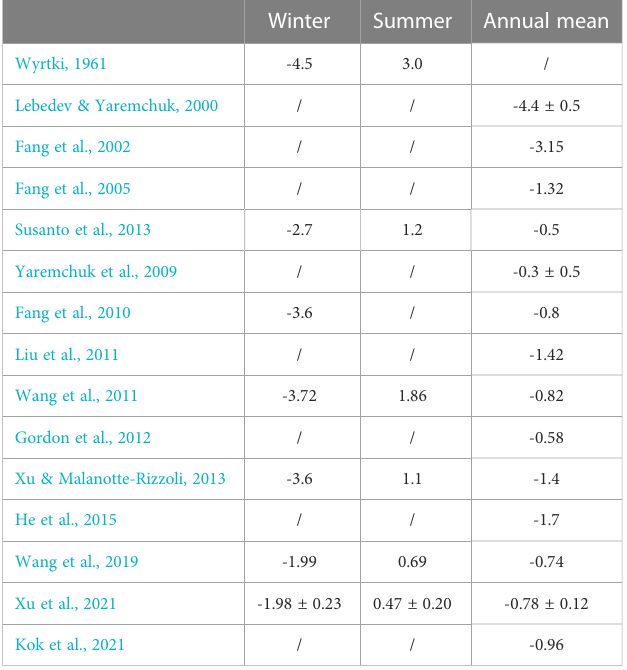
TABLE 1 Estimated volume transport values of KSTF (unit: Sv).